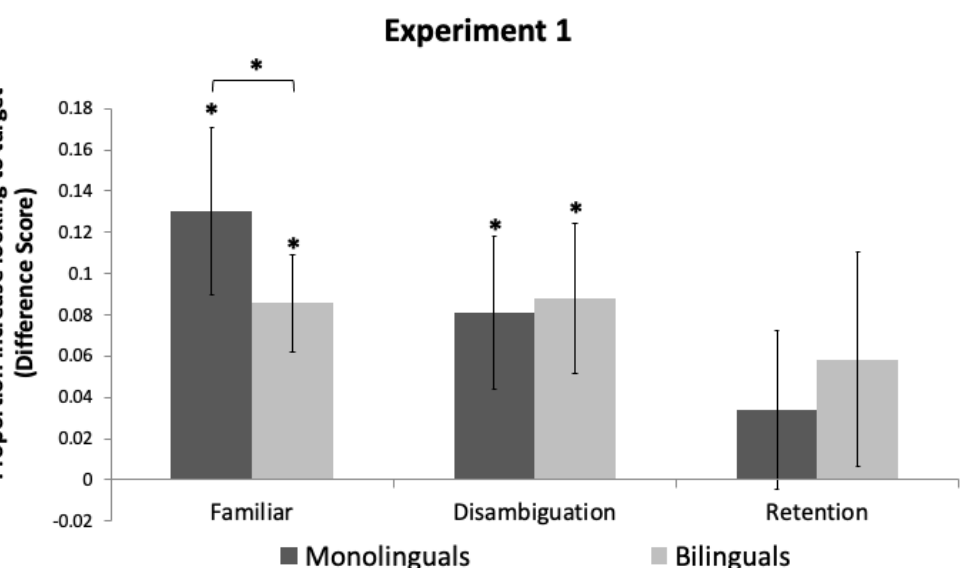
Figure 2. Difference scores and standard errors for Experiment 1. Positive scores indicate increased looking to the target object. * indicates a p -value smaller than 0.05.